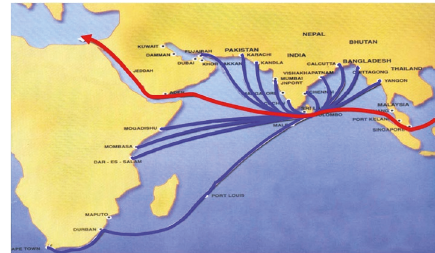
Figure 7: Shipping lanes around Sri Lanka (source: Sri Lanka Ports Authority).